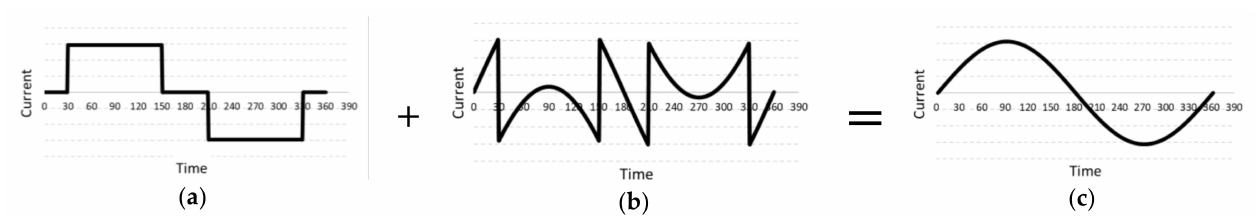
Figure 15. Current waveforms in phase a of the HTR. ( a ) Input current at rectifier 1. ( b ) Input current at rectifier 2. ( c ) Input current (sinusoidal) at